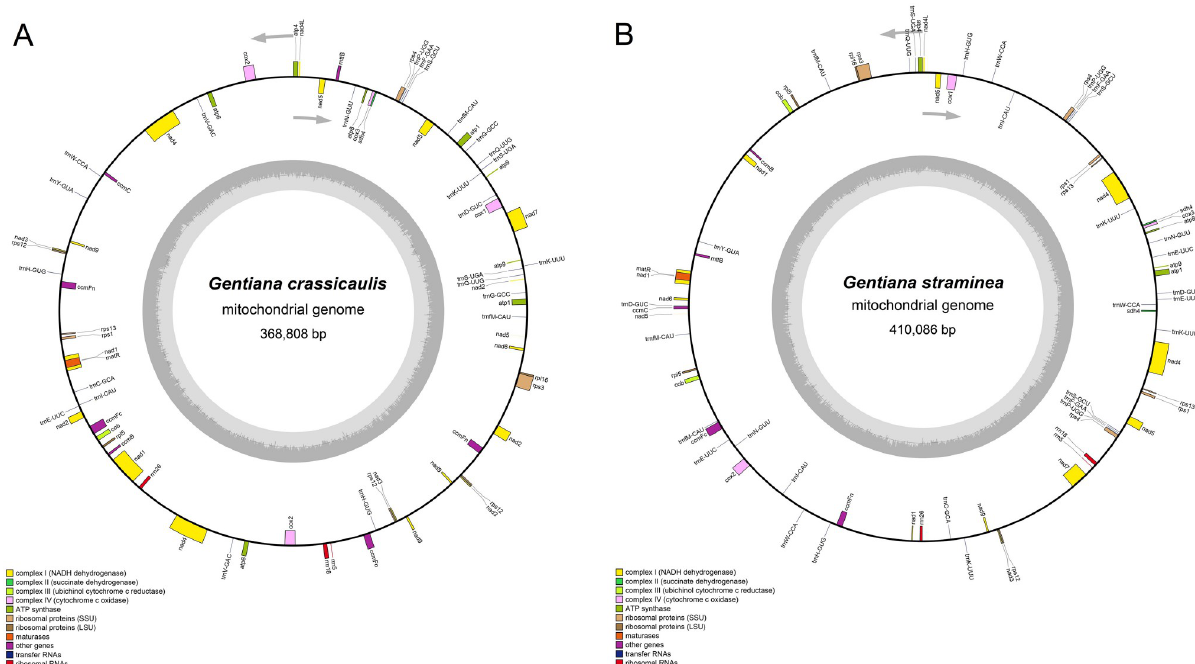
Fig 1. Mitochondrial genome map of Gentiana crassicaulis (A) and G . straminea (B). Genes (exons are shown as closed boxes) shown outside the curve are transcribed counterclockwise, whereas those inside are transcribed clockwise. Genes from the same protein complex are colored the same. https://doi.org/10.1371/journal.pone.0281134.g001 fragment. There are three copies of atp6 with the length of 71, 277 and 277 bp, respectively (Fig 2). Primers were designed for PCR amplification of atp6 regions in G . straminea , which further verified the accuracy of the sequences (S1 Data). An incomplete pseudogene of atp6 , which can be regarded as missing, is rare in mtDNAs of angiosperms.